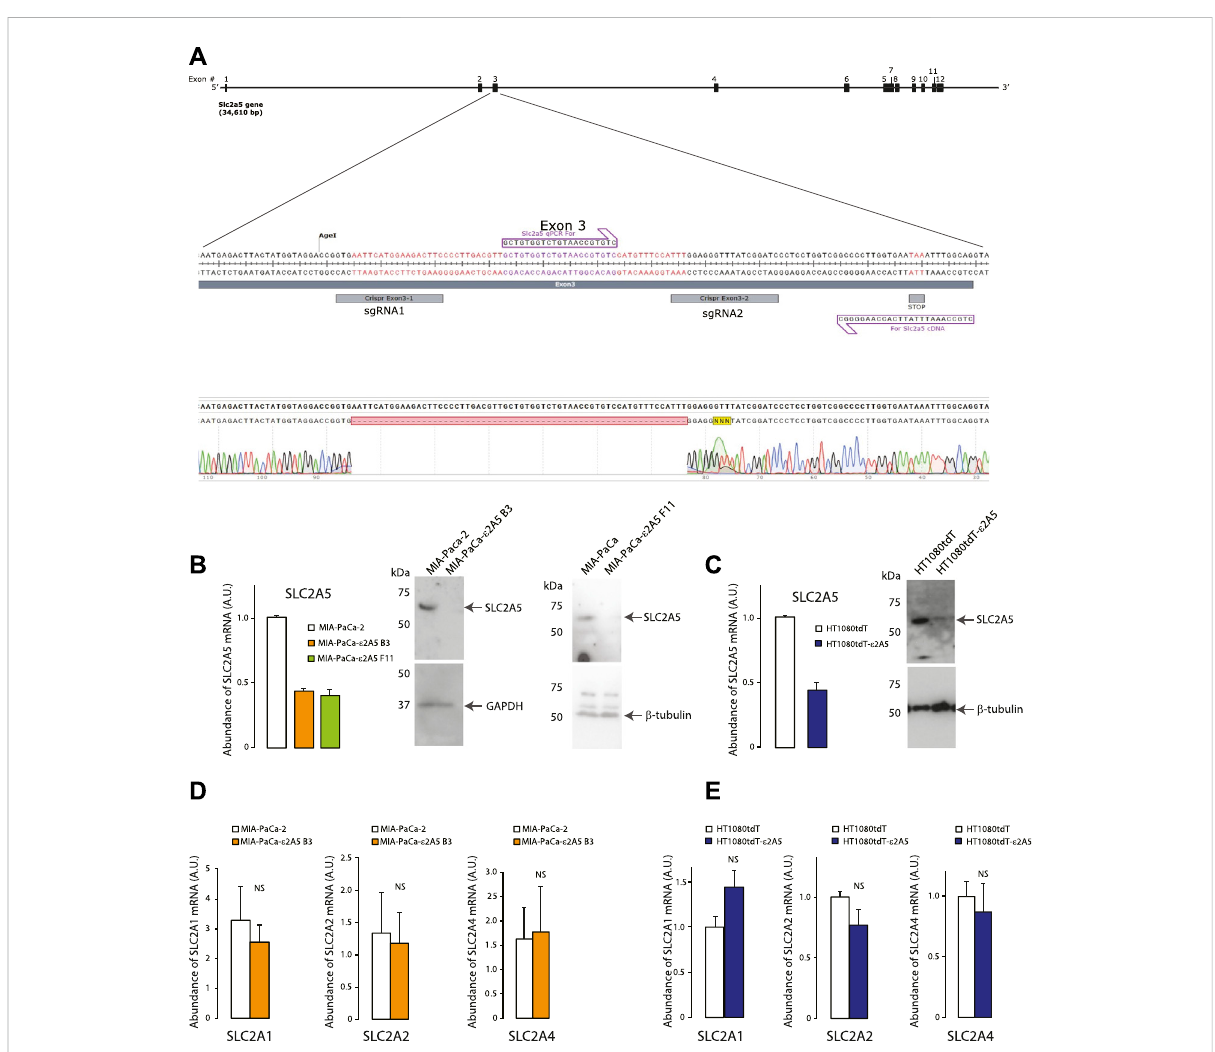
FIGURE 1 Editing of the SLC2A5 gene. (A) . Inactivation of the SLC2A5 gene in human MIA-PaCa-2 and HT1080tdT cells using CRISPR/Cas9-mediated in situ gene editing. Guide RNAs were targeted to Exon 3. Genomic DNA of edited cells was sequenced, and positive clones were identi fi ed as having a 62 base pair disruption, leading to an early stop codon 14 amino acids downstream of the disruption point. (B) . qPCR analysis of SLC2A5 mRNA abundance in MIA-PaCa-2 and MIA-PaCa- ε 2A5 cells (clones B3 and F11) (n = 3). DNA primers were designed to amplify Exon 12 of the SLC2A5 gene. Immunoblot analysis was carried out with antibodies directed at the C-terminus of SLC2A5. Anti- β -tubulin or anti-GAPDH antibodies were used to assess amounts of loaded protein samples. (C) . qPCR analysis of SLC2A5 mRNA abundance in HT1080tdT and HT1080tdT- ε 2A5 cells. DNA primers and control antibodies were as described above. (D) . qPCR analyses of SLC2A1, SLC2A2, and SLC2A4 mRNA abundance in MIA-PaCa- 2 and MIA-PaCa- ε 2A5 cells (n = 3). (E) . qPCR analyses of SLC2A1, SLC2A2, and SLC2A4 mRNA abundance in HT1080tdT and HT1080tdT- ε 2A5 cells (n = 3). All data in the Figure is representative of more than 3 biological replicates. NS, not signi fi